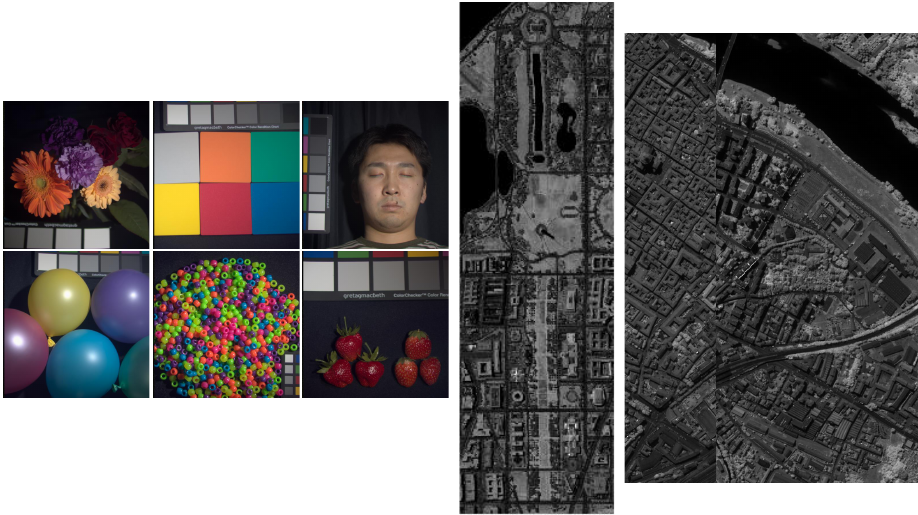
Figure 3. Visual exhibition of some typical scenes of the three datasets utilized in this